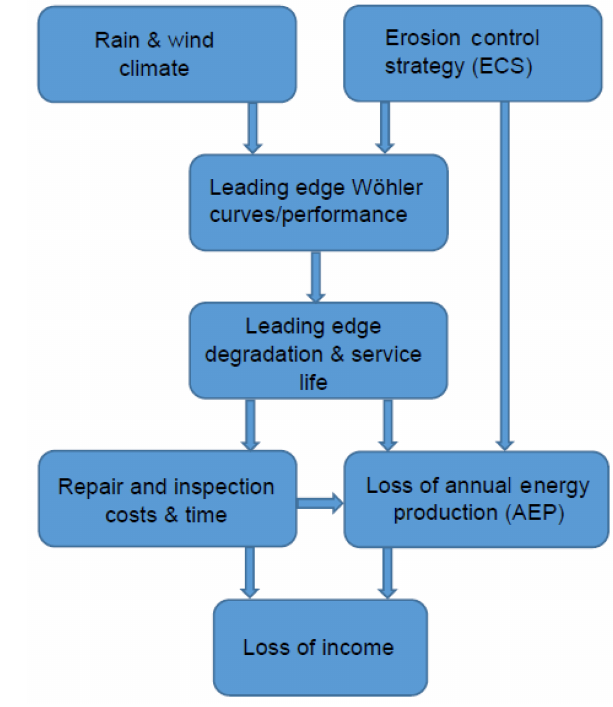
Figure 16. Illustration of the framework for calculating the loss of income due to leading-edge erosion.